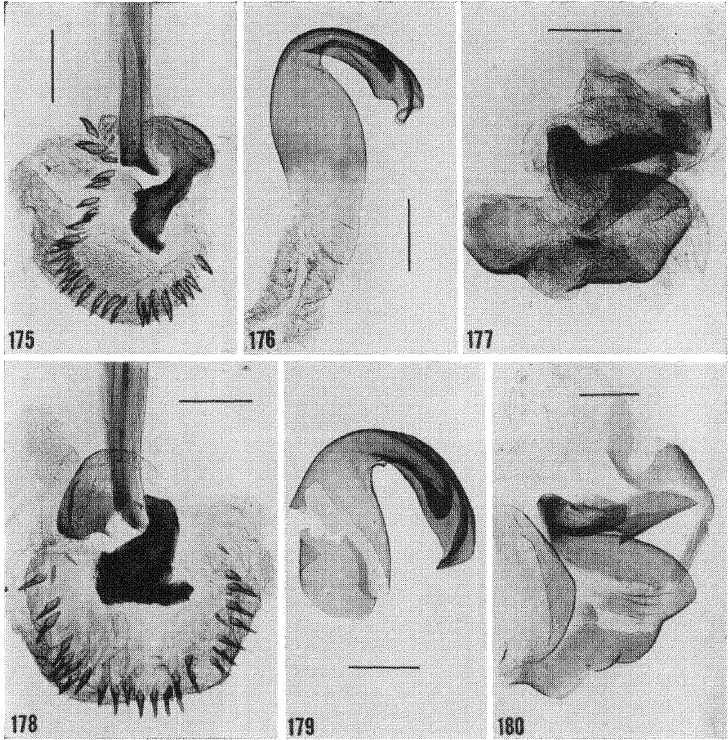
Figs. 175-180. 175-177. (57 MCZ). Phoetalia allida (Brunner). Point Antonio, Jamaica. 178-180. (38 BMNH). Phoetalia circumvagans Bur- meister. (seale 0.3